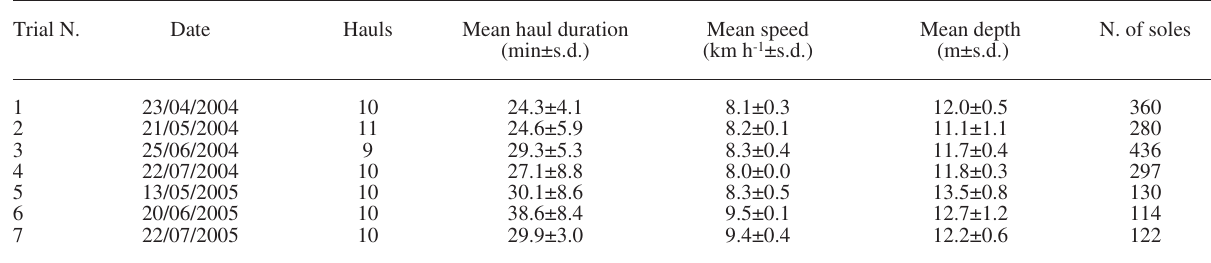
Table 3. – Fishing trials carried out with rapido trawls in the period spring–early summer 2004 and 2005. Trial